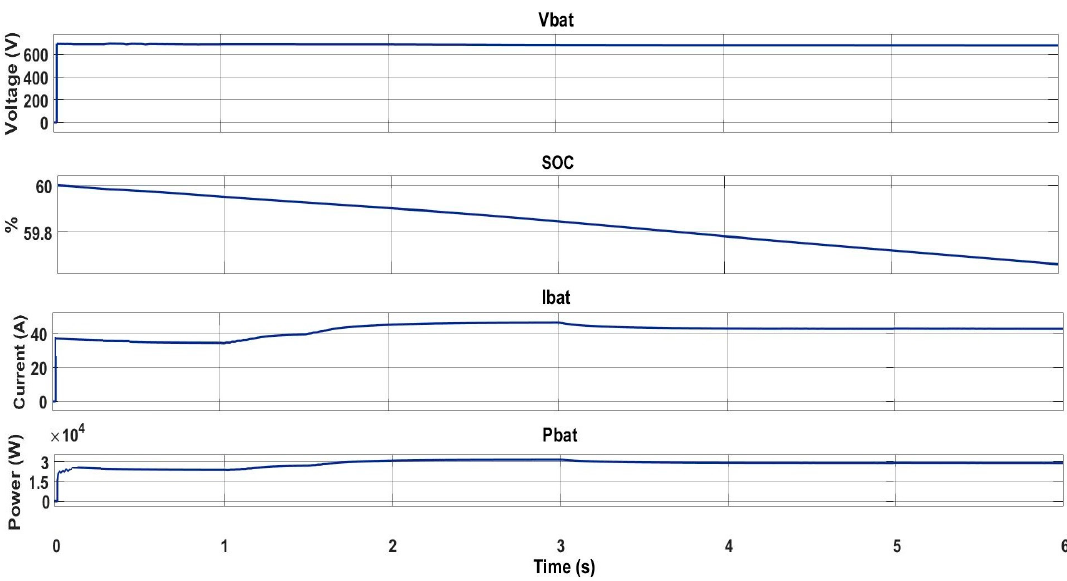
Figure 8. The battery voltage, current, SOC level and charge/discharge power variation.